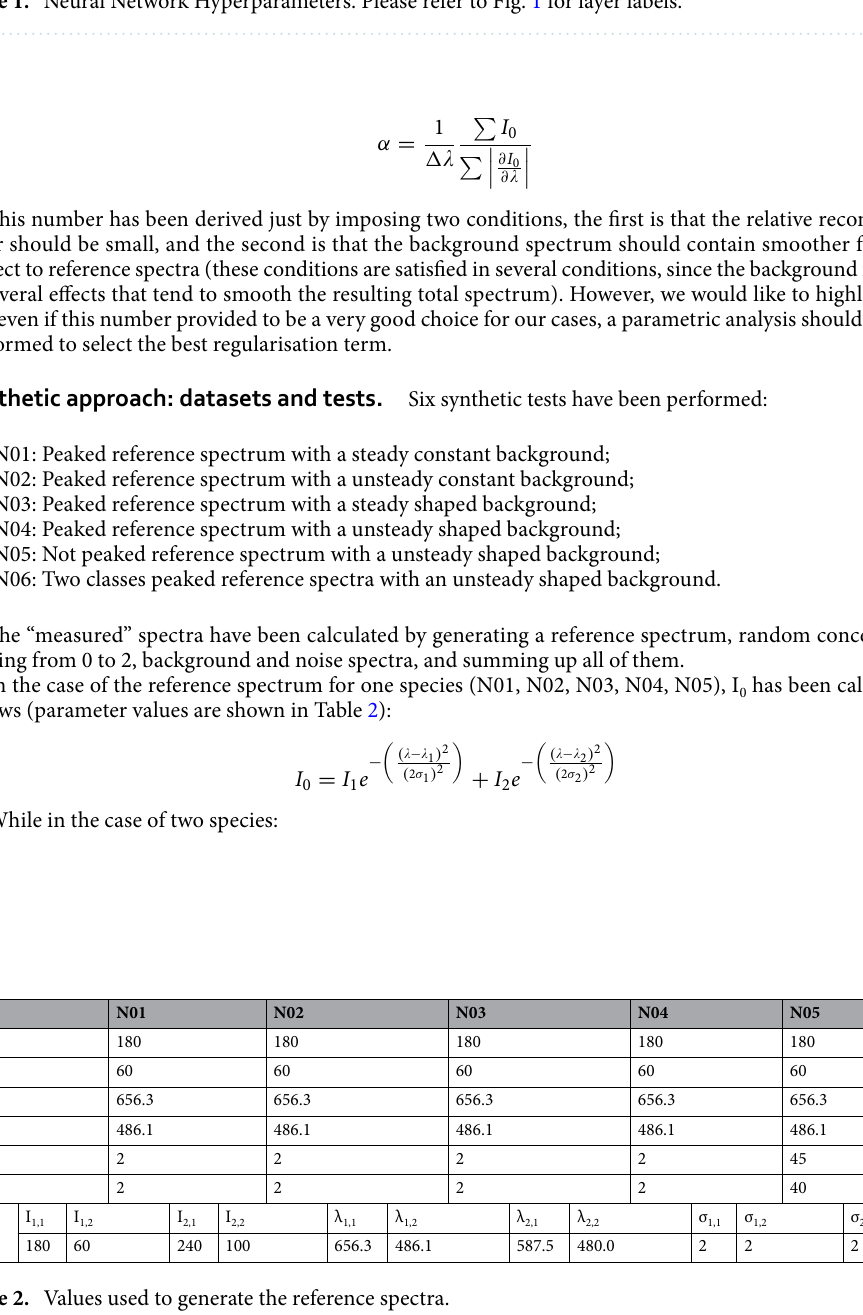
Table 1. Neural Network Hyperparameters. Please refer to Fig. 1 for layer labels.